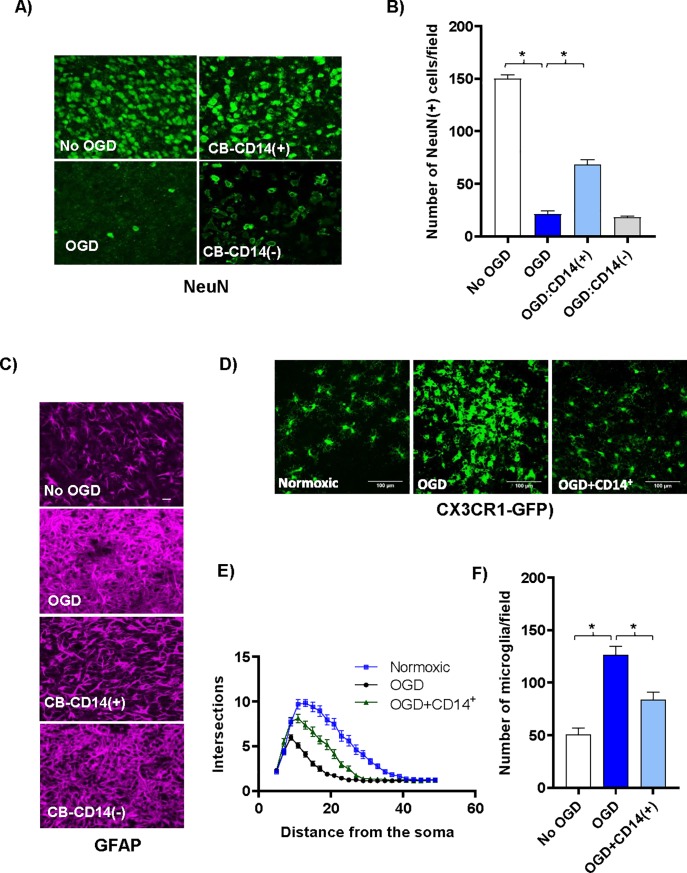
CB CD14+ monocytes protect neurons and reduce glial activation following OGD shock.(A) Confocal images (40x) of antibody stained neurons (green, anti-NeuN) in the periventricular region of control and cell treated brain slice cultures co-cultured three days with various CB cell populations following OGD shock. Top left panel shows control slices not exposed to OGD and cultured without human cells. All other panels show slices exposed to OGD prior to addition of human cells. Top right panel shows slices co-cultured with selected CB-CD14+ monocytes; and bottom right panel, with CB MNC depleted of CD14+ monocytes. (B) The average number of NeuN+ neurons in 40x high-powered fields (HPF) located along the periventricular region was determined. Values shown are means +/- standard deviation. N = 3 slices under each condition. Statistically significant differences (p<0.01) compared to the OGD control are indicated by asterisks. (C) Confocal images (40x) of antibody stained astrocytes [magenta, anti- GFAP] in the periventricular region of control and cell treated brain slice cultures co-cultured three days with various CB cell populations following OGD shock. Top row shows control slices not exposed to OGD and cultured without human cells. All other rows show slices exposed to OGD prior to addition of CB cells. Third row shows slices co-cultured with CB-CD14+ monocytes; fourth row, with CB MNC depleted of CD14+ monocytes. (D) Representative confocal images of microglial cells in CX3CR1-GFP+/- mouse brain slice cultures and numbers are shown. (E) Sholl profiles of microglial cells in brain slices of normoxic, OGD-shocked and OGD-shocked treated with CBCD14+ cells. Intersections were counted at 2μm intervals from the soma center to a radius of 5 μm to 50 μm. Curves represent mean intersection values ±SEM. (F) Number of microglia in control and OGD-treated brain slice cultures with and without added CB CD14+ cells.